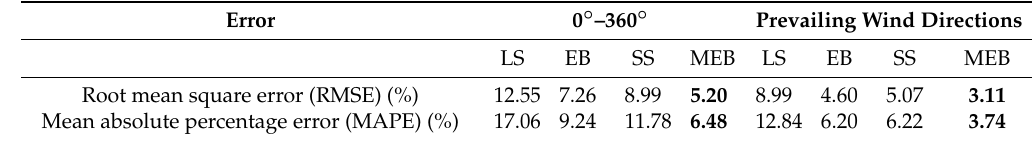
Table 1. Simulation error of the park efficiency using different models.